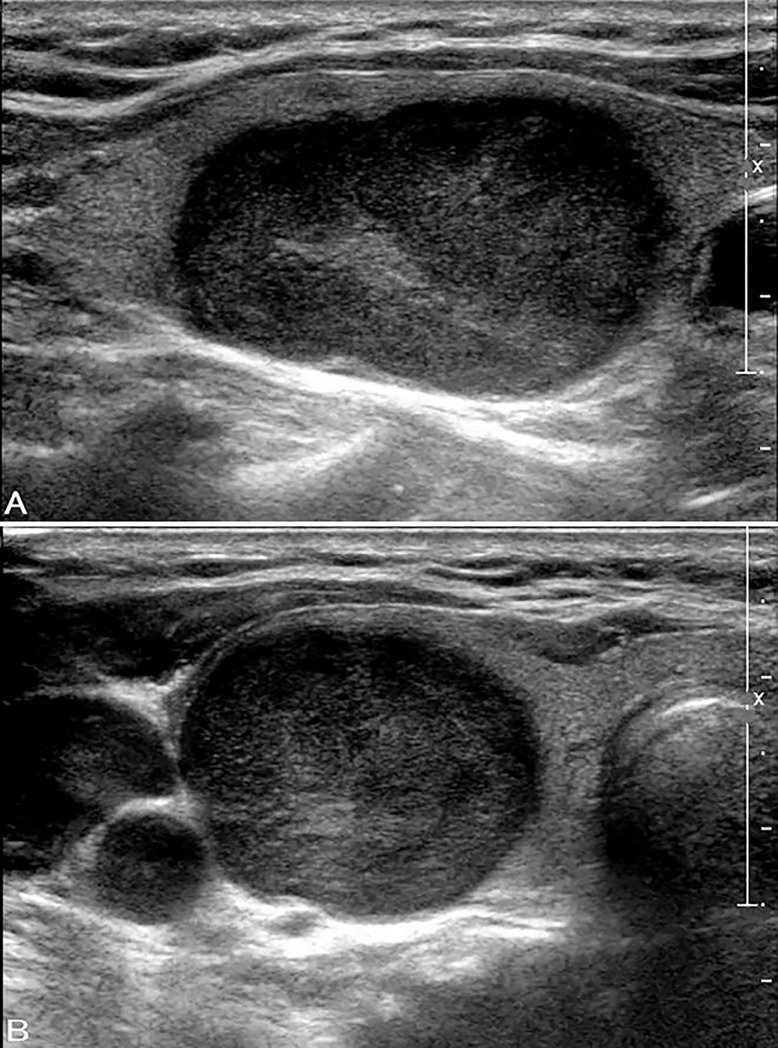
Ultrasound images in a patient with FTC in the right lobe.A, B. Longitudinal (A) and transverse (B) US show a very hypoechoic solid thyroid nodule (size: 32 mm × 19 mm × 24 mm) with wider-than-tall shape and smooth margins. The nodule was classified as ACR TIRADS category TR4. The cytological diagnosis was follicular neoplasm with negative K-RAS mutation.